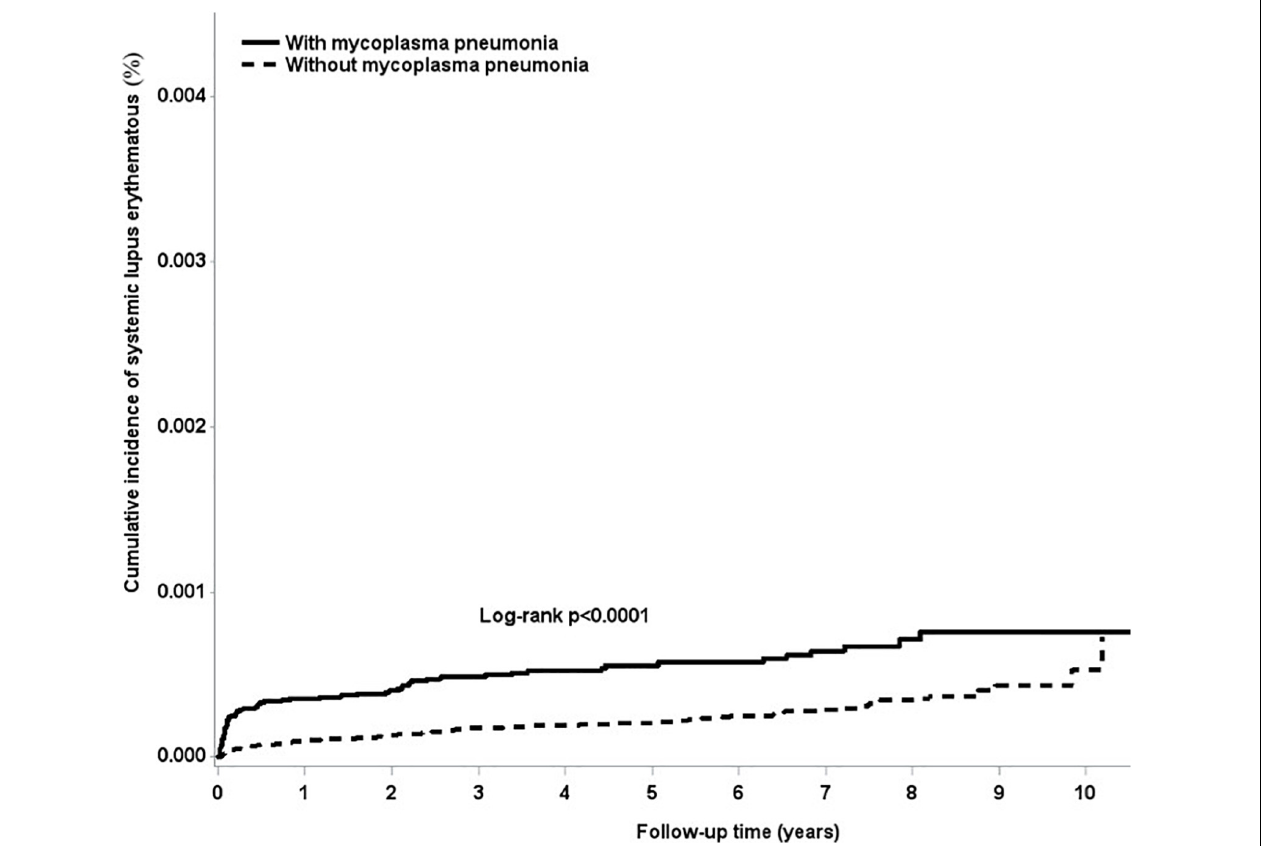
FIGURE 1 | Cumulative incidence of systemic lupus erythematosus in the study